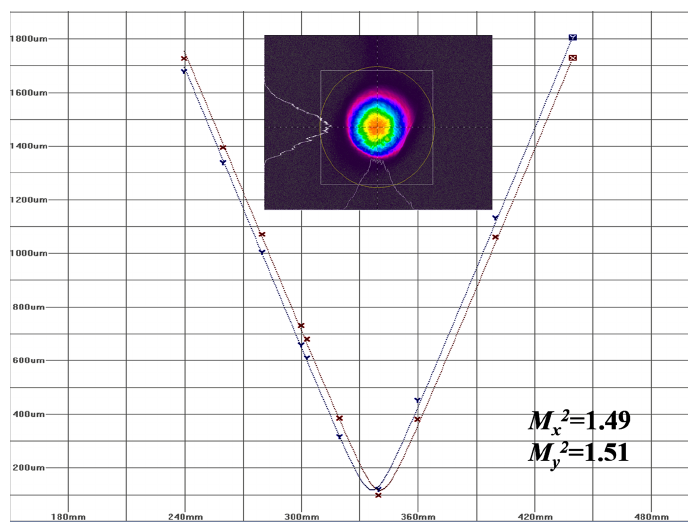
Figure 8. Beam quality of the laser source.